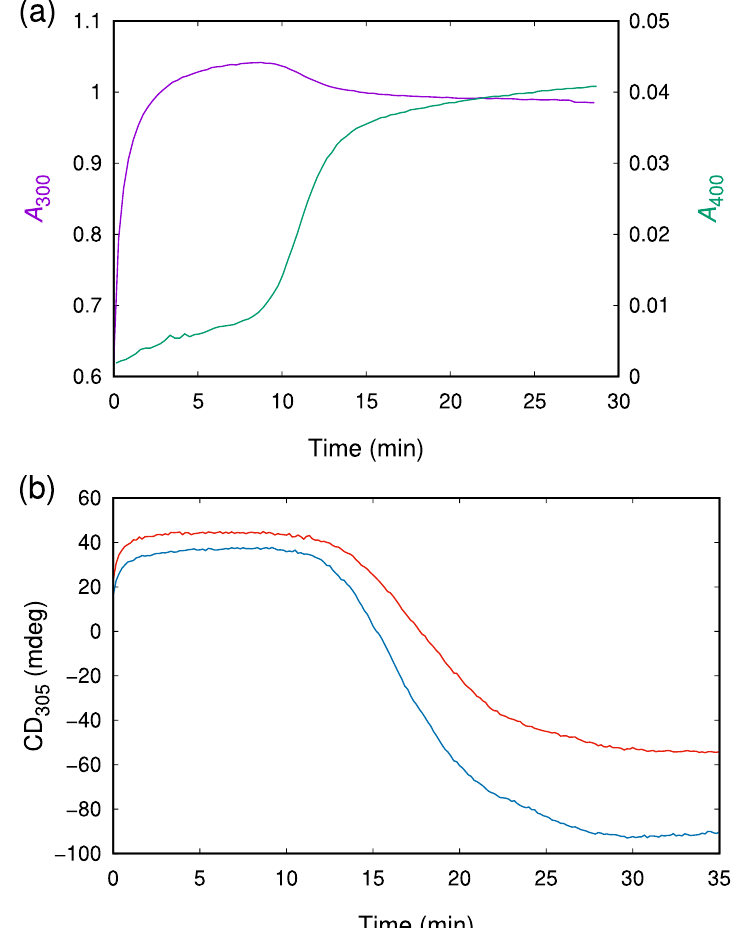
Figure 7. Time courses of the absorbances for 300 (magenta line) and 400 nm (green line) of a single measurement ( a ) and CD time records at 305 nm of two (red and blue lines) independent experiments ( b ). Initial concentrations: 10 mM HClO 4 , 300 µ M NAC, 300 µ M Cu 2+ ; 20 ◦ C. The records were acquired on the conventional double-beam spectrophotometer ( a ) with a period of 17 s alternating between 300 nm and 400 nm and on the CD spectrometer ( b ) with a data pitch of 10 s (shutter